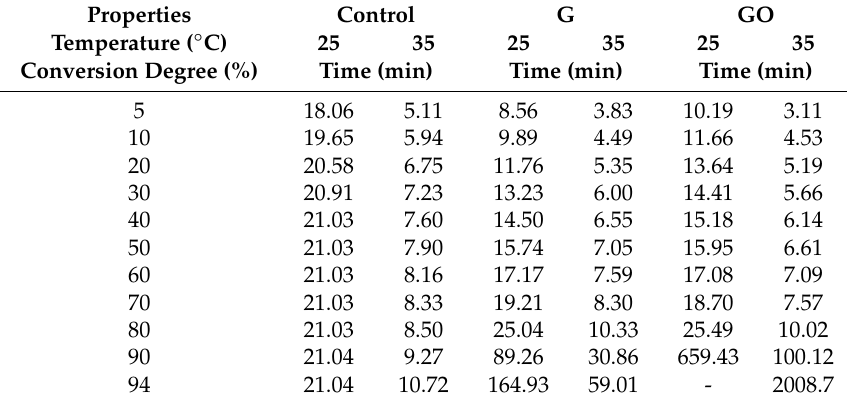
Table 2. Model free kinetics (MFK) simulation data at 25 and 35 °C for the control, 0.1 wt.% GO-, and 0.1 wt.% G-PMMA bone cements.